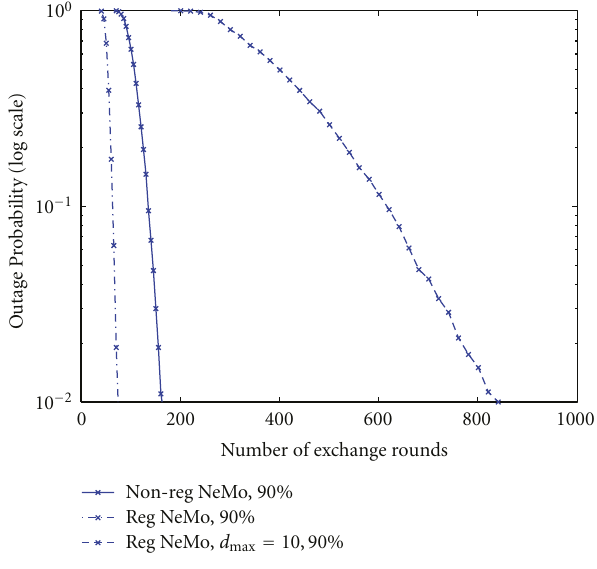
Figure 6: Outage performance.